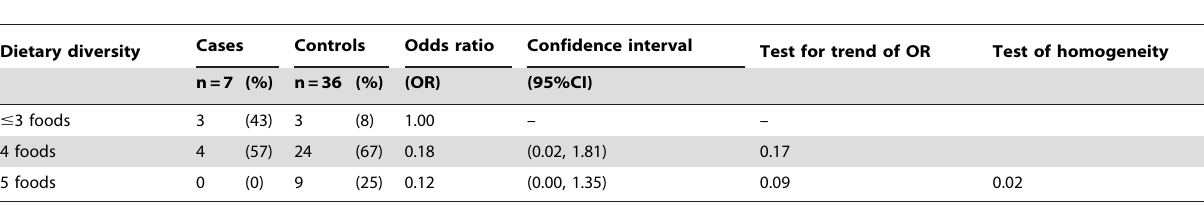
Table 3. Diversity of diet among cases of peripheral neuropathy, Papua New Guinea, 2010.